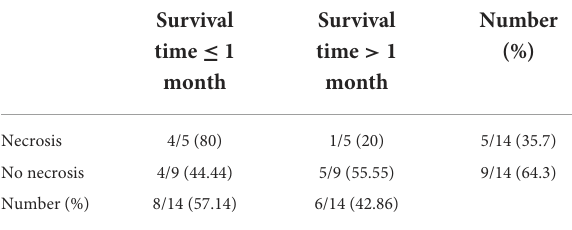
TABLE 7 Survival time at 1 month in 14 cats with or without necrosis observed in tumoral tissue samples. Survival Survival time ≤ 1 time > 1 month month